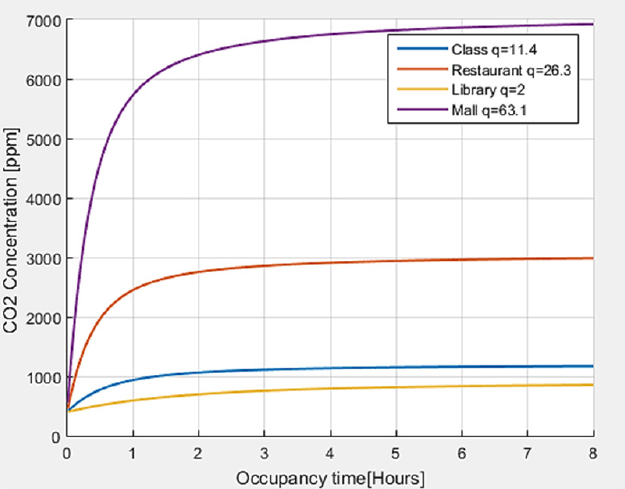
Figure 7. CO 2 concentration with respect to permanence time for different indoor environments.